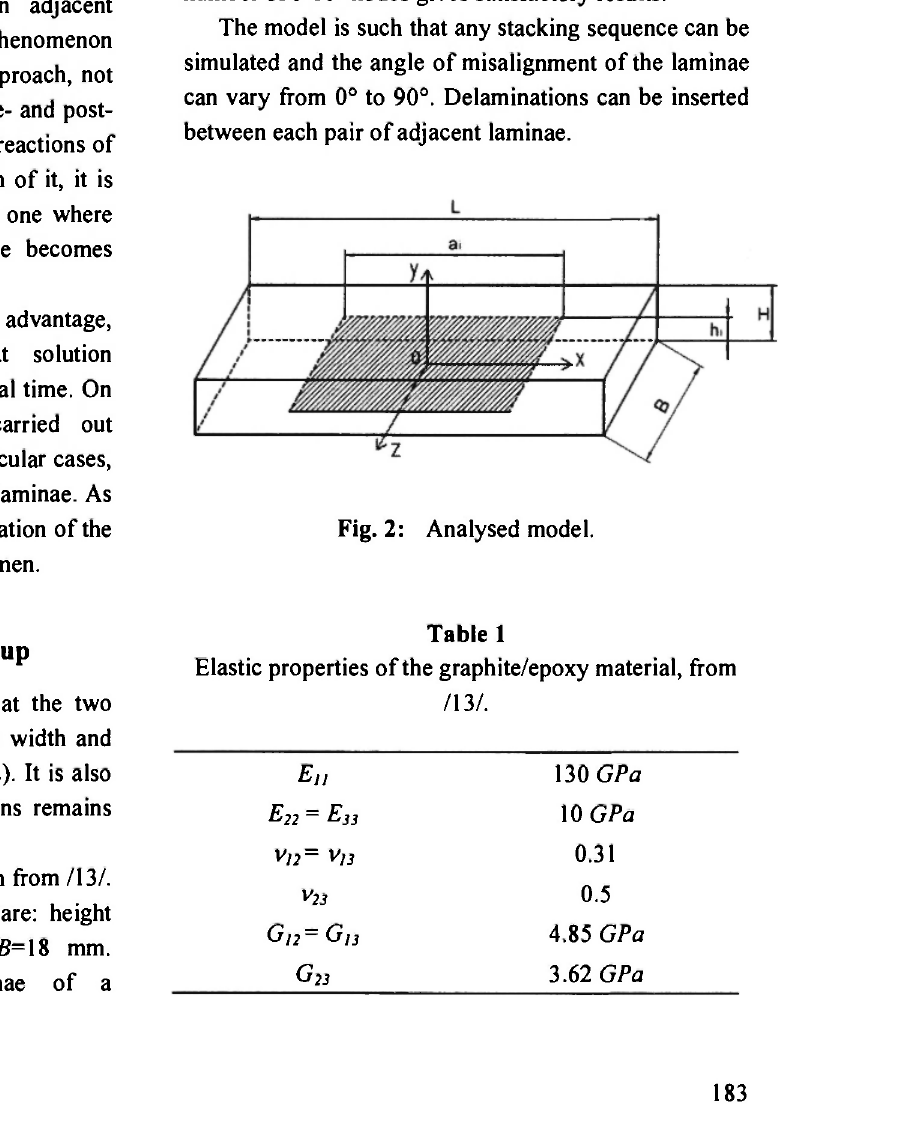
Fig. 2: Analysed model.